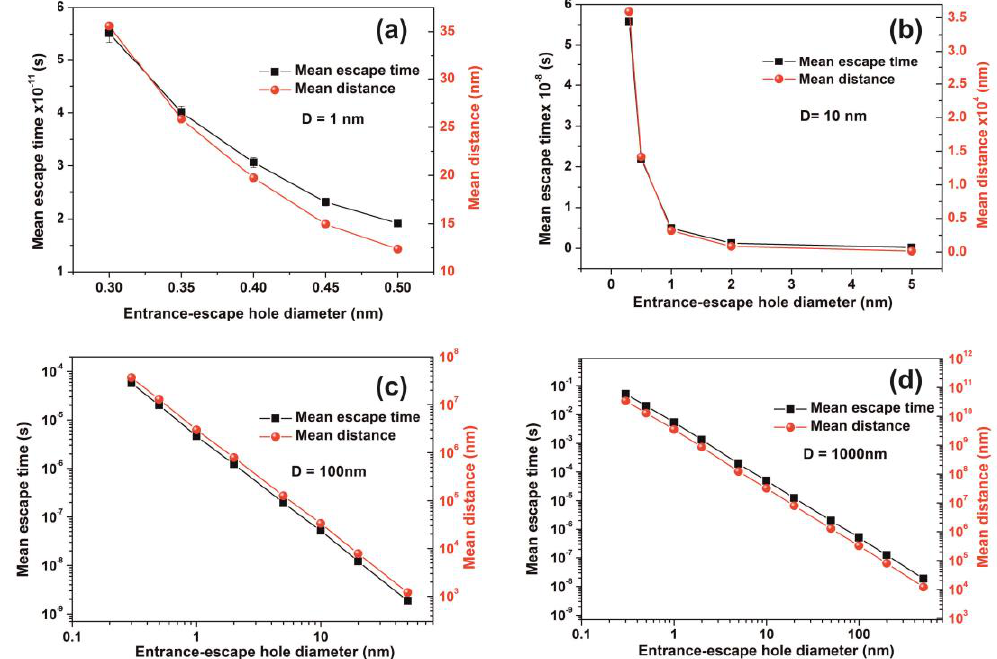
Figure 14. Mean escape time and mean travelling distance of a molecule within cavities of different geometries. ( a , b ) Gradient of the mean escape time and the mean distance that a molecule travels in the cavity before it escapes with different entrance-escape holes is diverging for very small size cavities (1, 10 nm); ( c , d ) mean escape time and the travelling distance gradients are constant for large size cavities (10 2 , 10 3 nm), suggesting a non-thermal equilibrium state and large fluctuations for small size cavities.